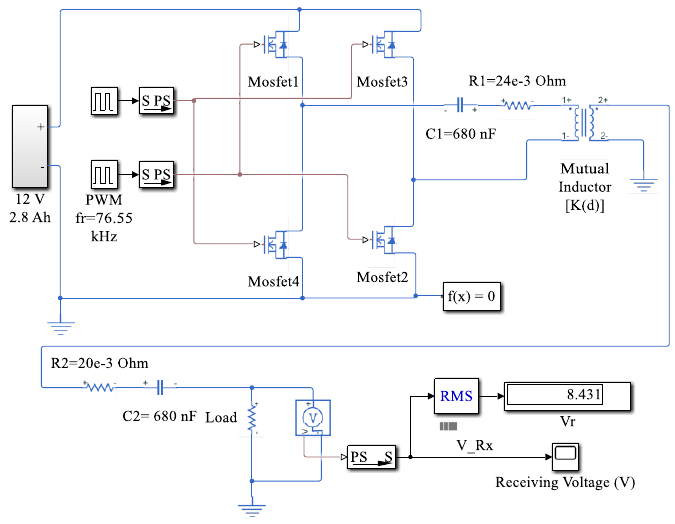
Figure 10. Open-loop SIMULINK model for estimating K (d) based on practical tests.